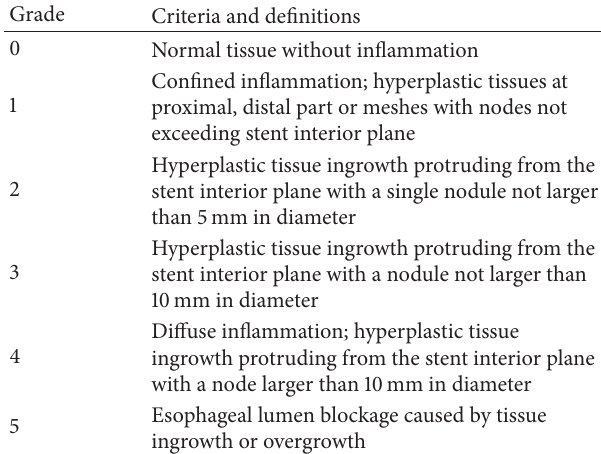
Table 1: Grading system for degree of esophageal tissue reaction: